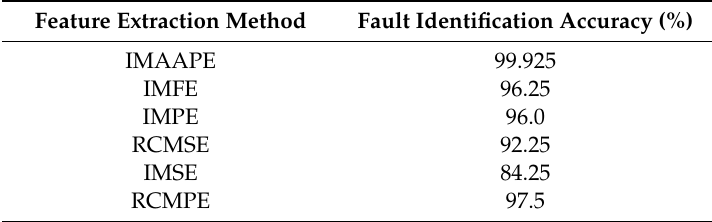
Table 13. Rolling bearing fault identification accuracy of di ff erent fault extraction methods combined with the mRVM.